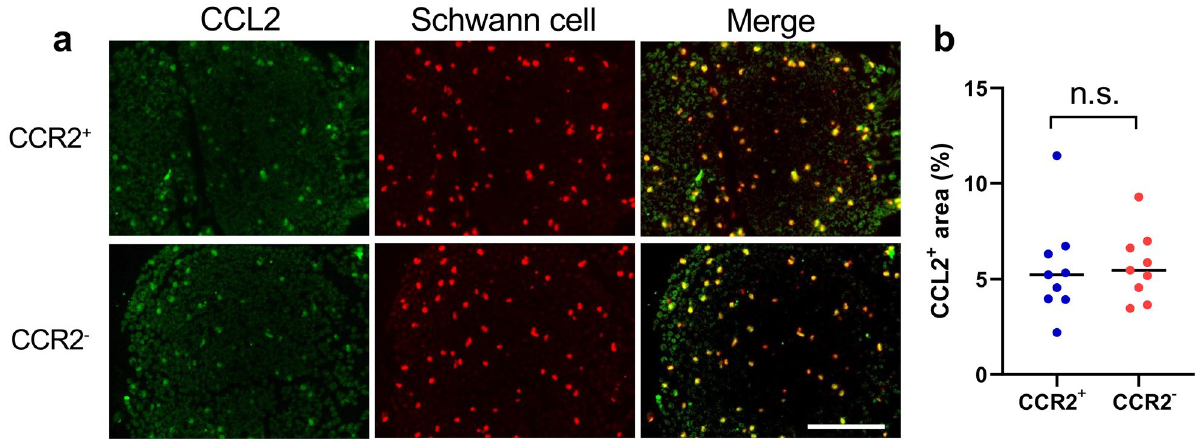
Figure 8. CCL2 production by Schwann cells. ( a ) Double immunostaining of CCR2-deficient and CCR2- positive SOD1 G93A mouse sciatic nerves at 16 weeks with anti-Schwann cell and anti-CCL2 antibodies. The merged images of both antibodies indicate the production of CCL2 by Schwann cells in both mouse genotypes. Scale bar: 20 μm. ( b ) The CCL2 + area (%) was not significantly different between CCR2-deficient and CCR2- positive SOD1 G93A mice. The horizontal line represents the mean value. The unpaired t test was used for statistical comparisons ( p = 0.92, n = 9). n.s. = not